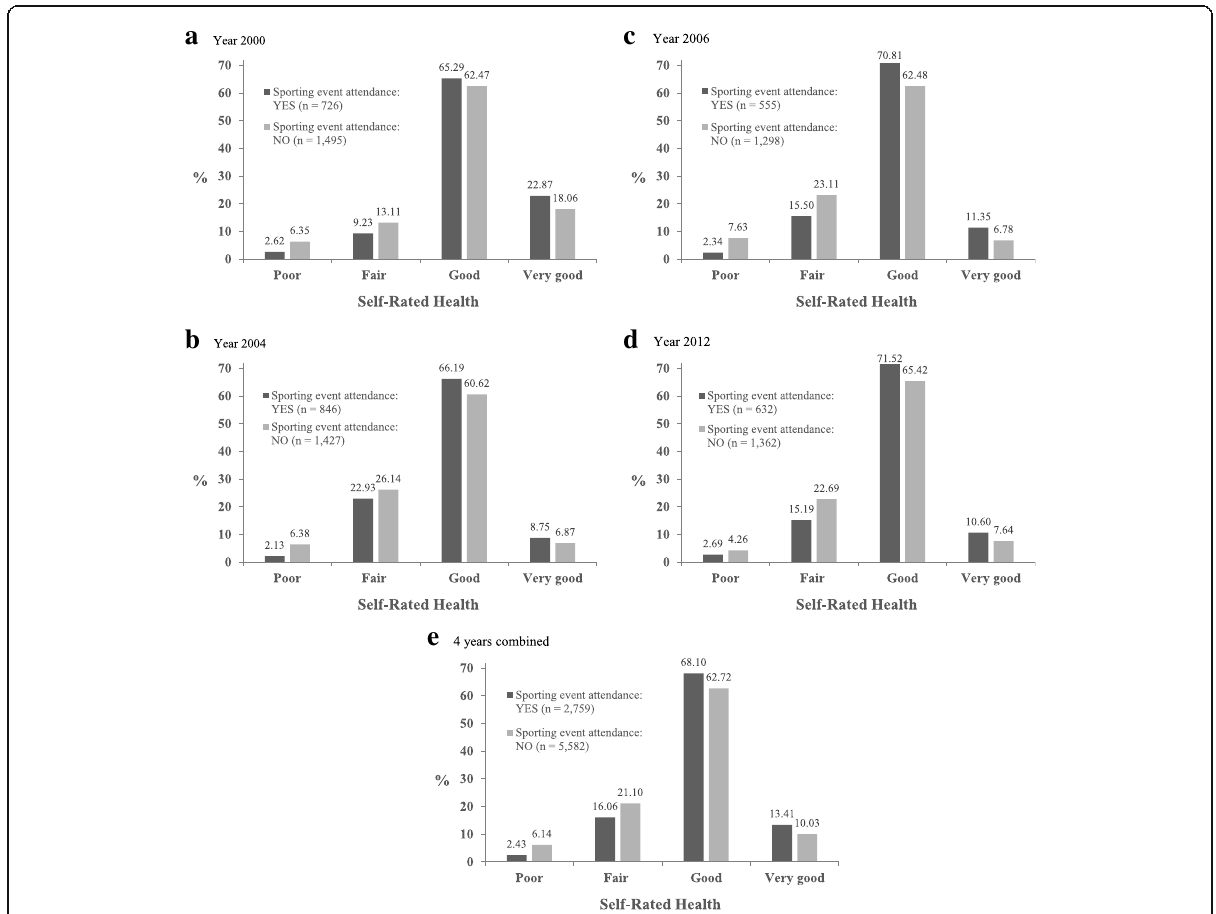
Fig. 2 Distribution of Self-Rated Health Categories for Sporting Event Attendees and Non-Sporting Event